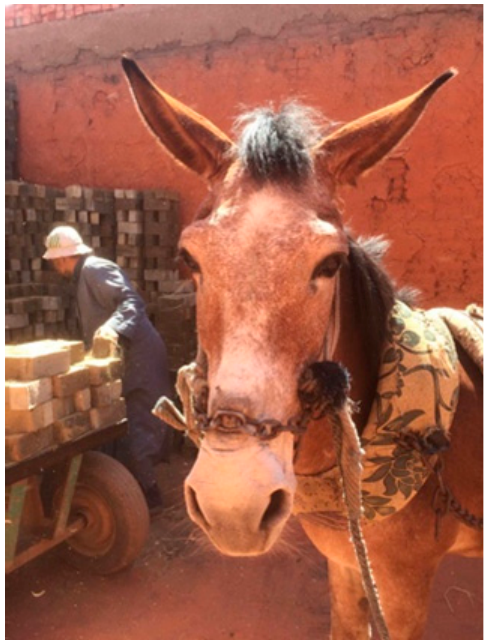
Figure 3. Another example of harsh equipment being used to control a mule working in an Egyptian brick kiln. The chain is purposefully used to create lesions on the nose to sensitize the mule to further pressure. Improved understanding of mule behavior would decrease the need for abusive tools such as this.